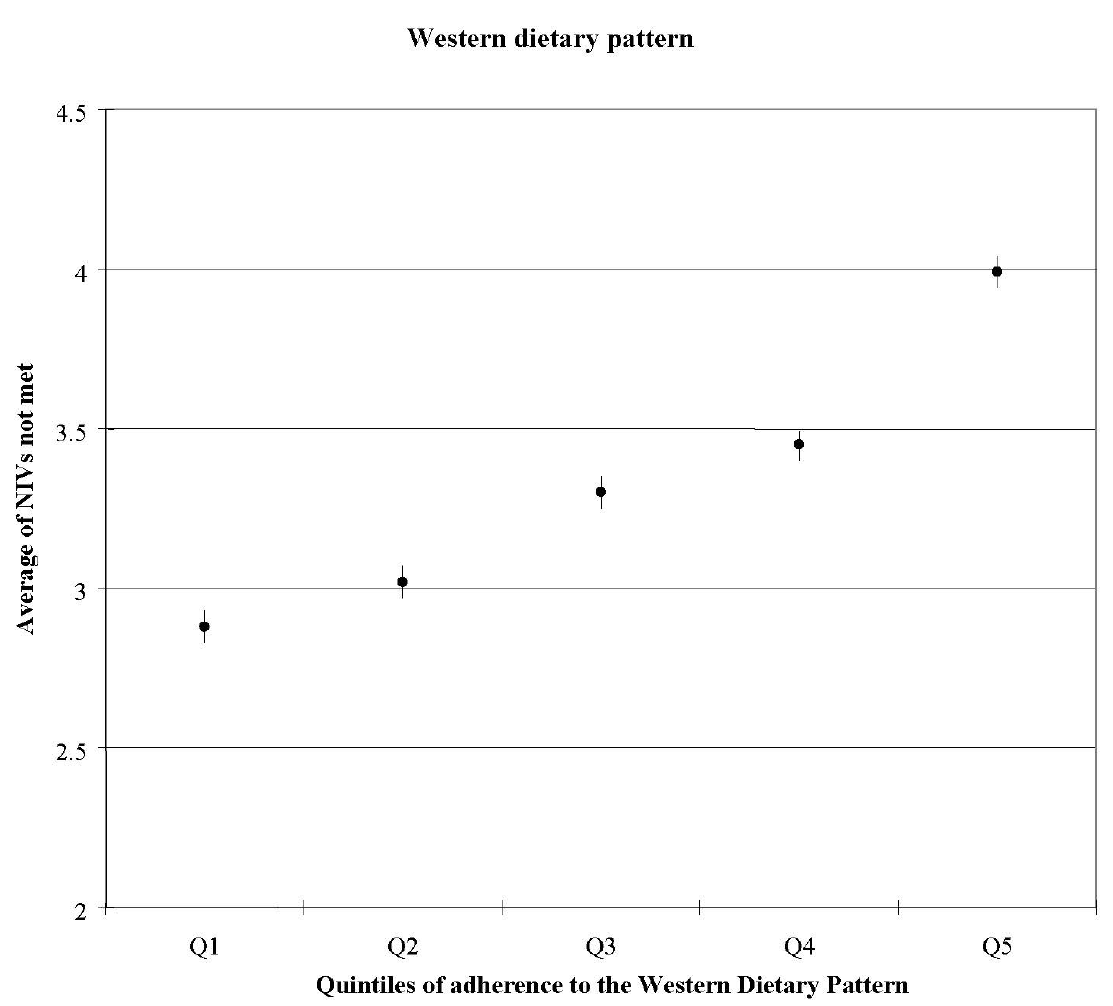
Figure 2. Average number of nutrients with intakes not meeting recommended levels across quintiles of Western Diet pattern score; adjusted for age and sex